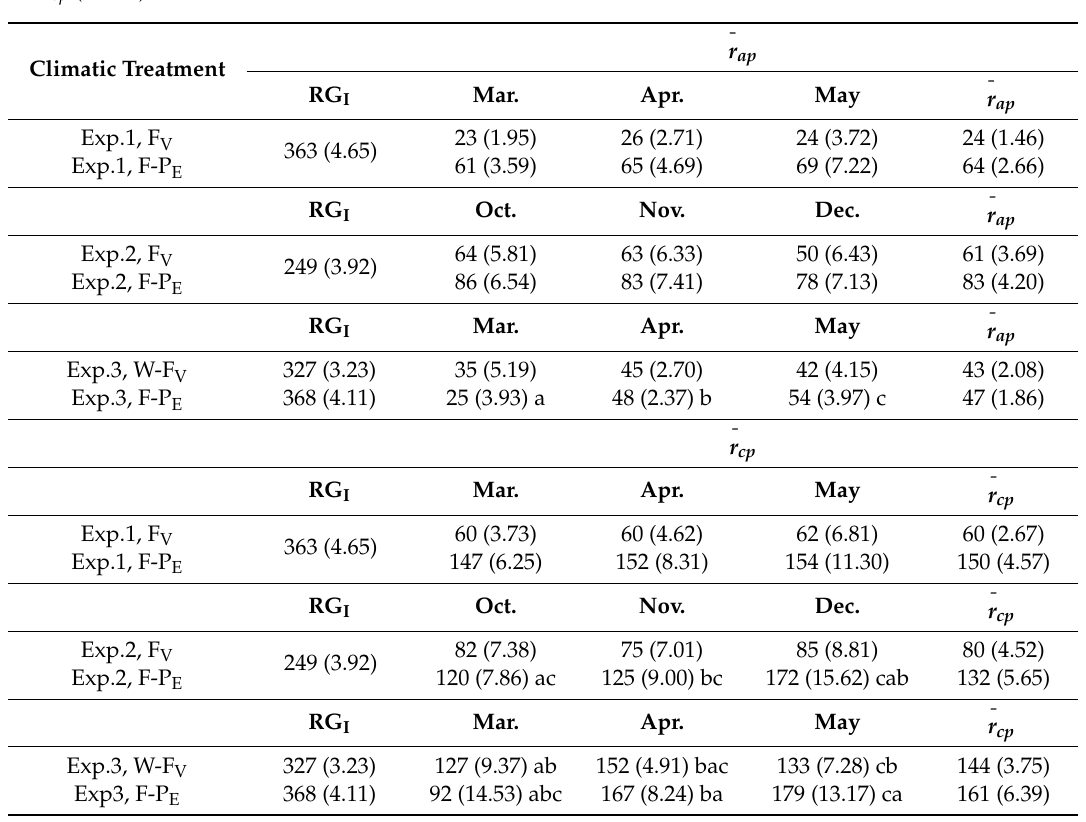
Table 3. Mean calculated values ( ± standard error) of aerodynamic r ap (s m − 1 ) and canopy resistances r cp (s m − 1